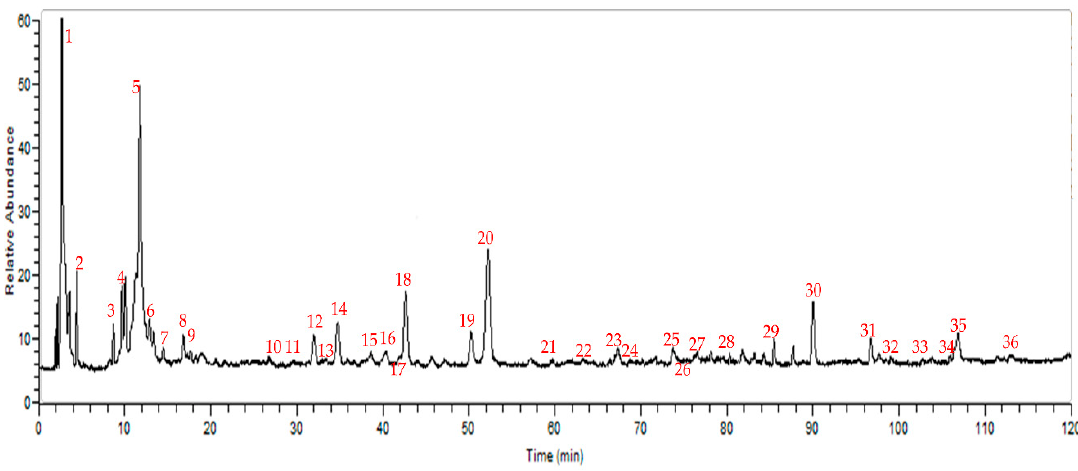
Figure 3. Total ion chromatogram of the fruit of C. fistula in negative-ionization mode.